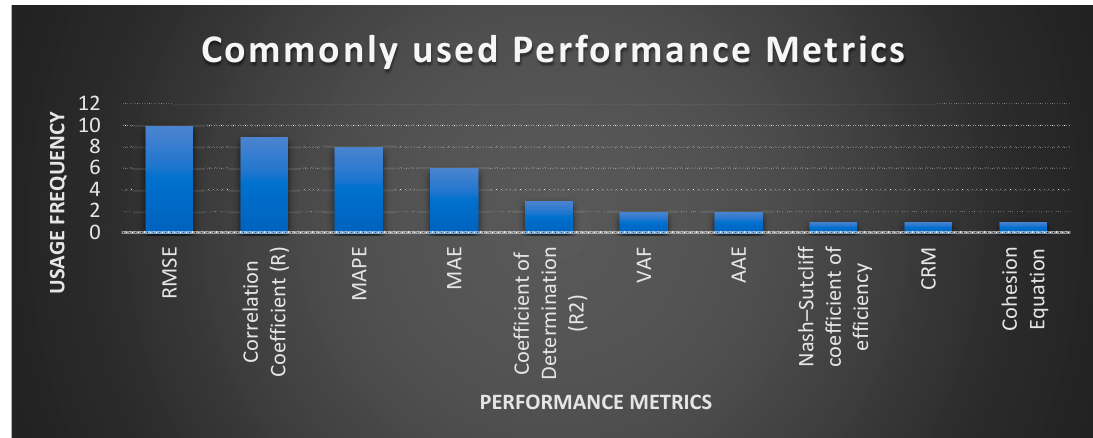
Figure 12. Commonly used performance metrics in the prediction of soil shear strength and project cost. Furthermore, according to the usage frequency of various AI-based models, it was found that ANN topped the list for the prediction of soil shear strength and pre-project cost and duration, followed by regression- and SVM-based models. A complete list of AI-based models used by various articles on the basis of their usage frequency is shown in Table 9 and Figure 13. Table 9. Most commonly used AI techniques for predicting the soil shear strength and pre-project cost and duration. AI Technique